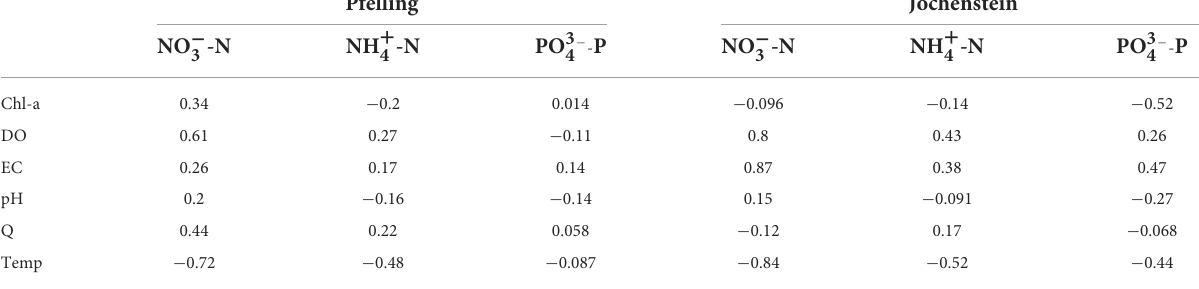
TABLE 4 Pearson’s r for each of the target variables concerning the six